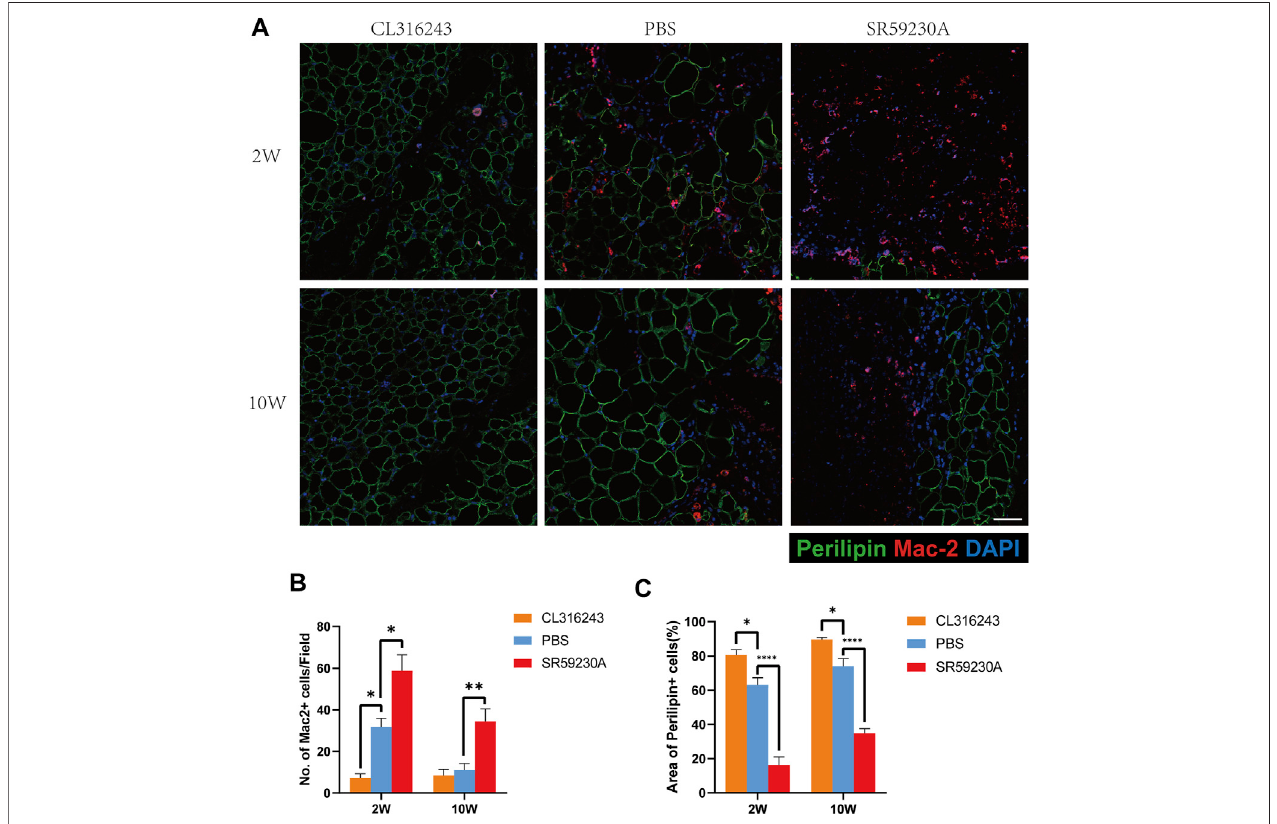
FIGURE 5 | Assessment of adipogenesis and in fl ammation in fat grafts following transplantation. (A) Tissue sections harvested at week 2 and week 10, doubly immunostained forperilipin (green) and Mac2(red). Fatgrafts inthe browning upregulationgroup have the mostnormal adipose structure, with few macrophages within fat grafts, whereas samplesfrom both the controland browning downregulation groups show severe in fl ammatory immunecell accumulation at week2. Atweek 10, fat grafts in the browning upregulation group and the control group have less in fl ammatory macrophages in grafts than the downregulation group. Compared with downregulation group, samples in control group and upregulation group have normal adipose structure at week 10. (B) Number of Mac2+ cells in each group. (C) Area of perilipin positive adipocytes in each group. (* p < 0.05;** p < 0.01;**** p < 0.0001) .Scale bar = 50 μ m.